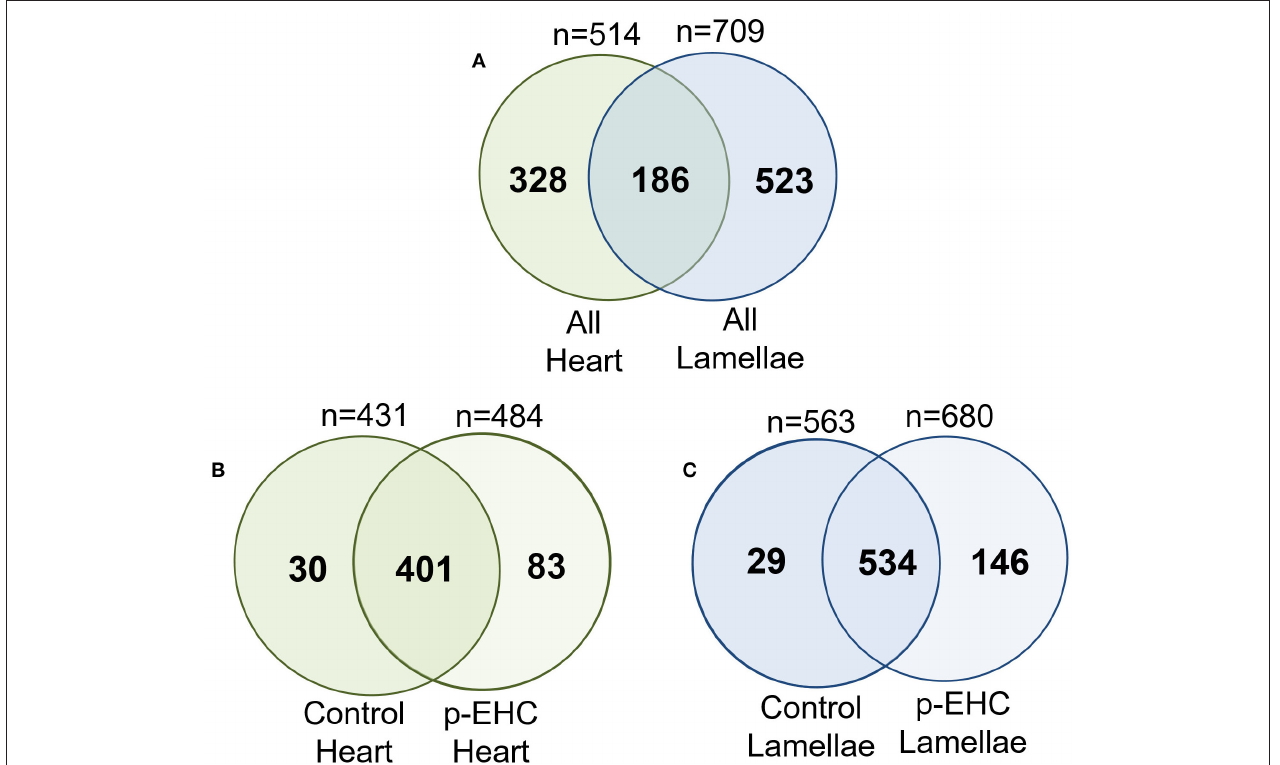
FIGURE 3 | Venn analysis of all identified proteins from the cardiac and lamellar tissues of control and hyperinsulinemic (p-EHC) horses identified overlap in protein groups between (A) all heart and all lamellae samples, (B) control heart and hyperinsulinemic heart samples, and (C) control lamellae and hyperinsulinemic lamellae samples. n = 4/group.